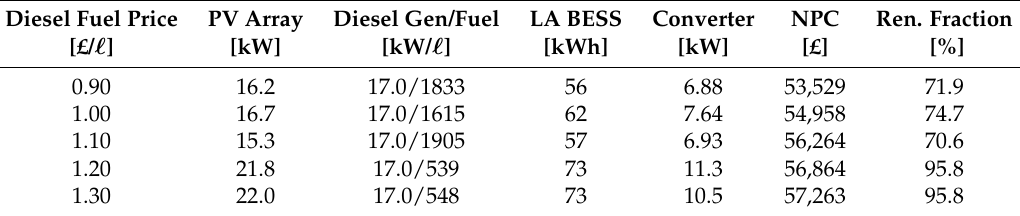
Table 5. Sensitivity analysis of diesel fuel